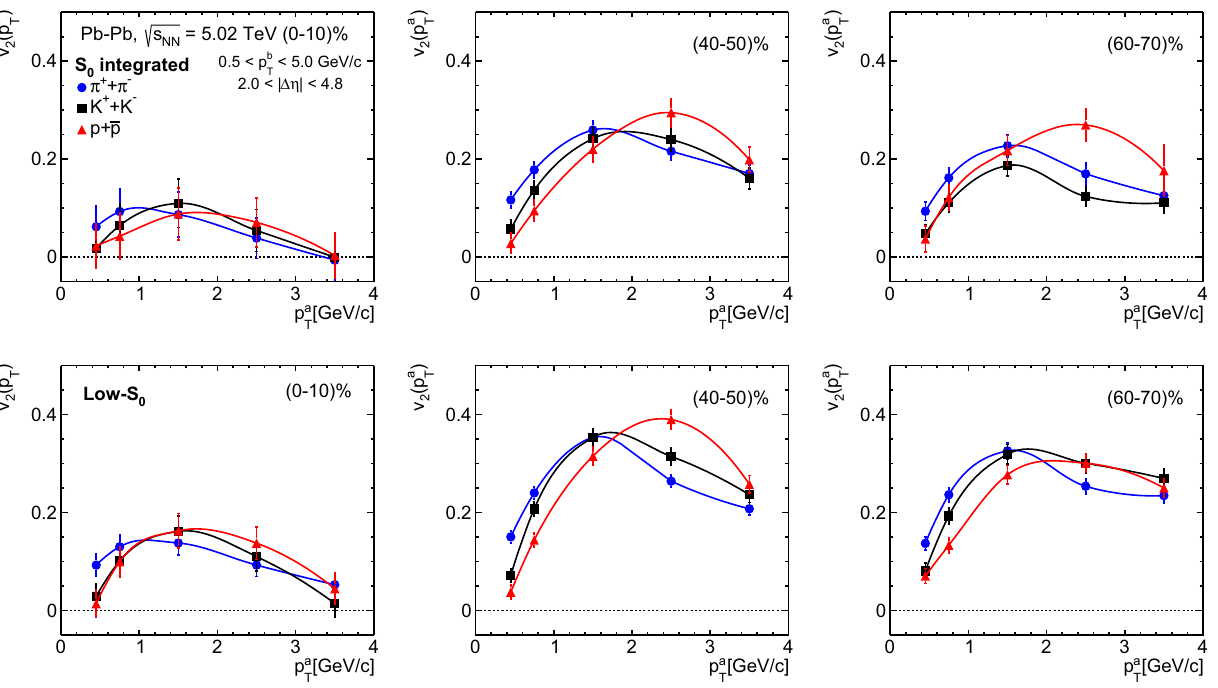
)) as a function of p a of pions (blue circles), kaons (black squares) and protons √ T T s NN = 5 . 02 TeV using AMPT